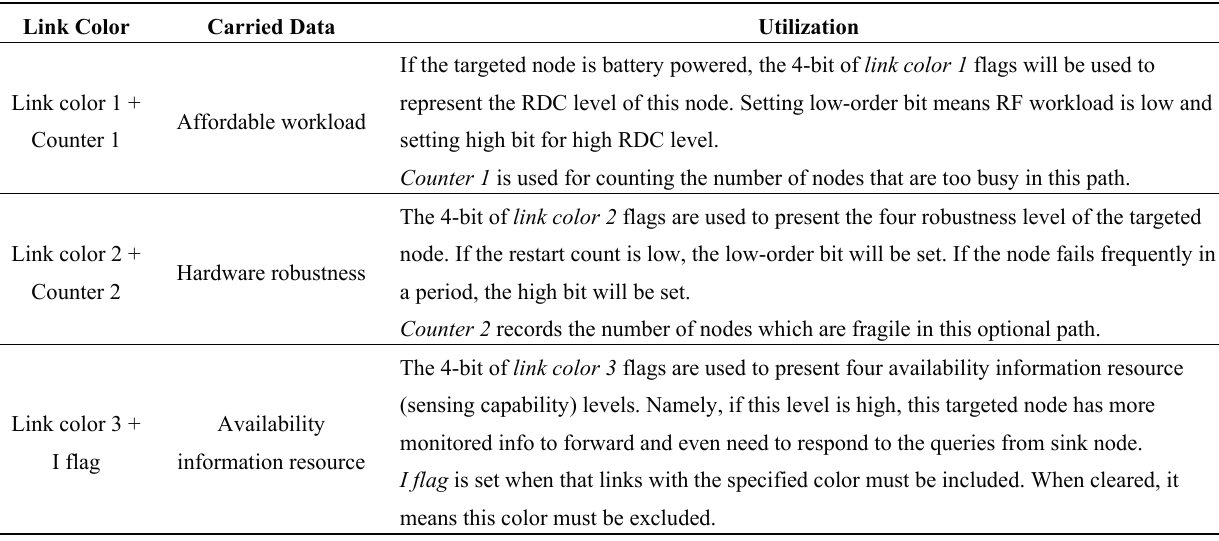
Figure 3. Link color metric and its piggyback format. Table 4. Utilization and explanation of the three link color